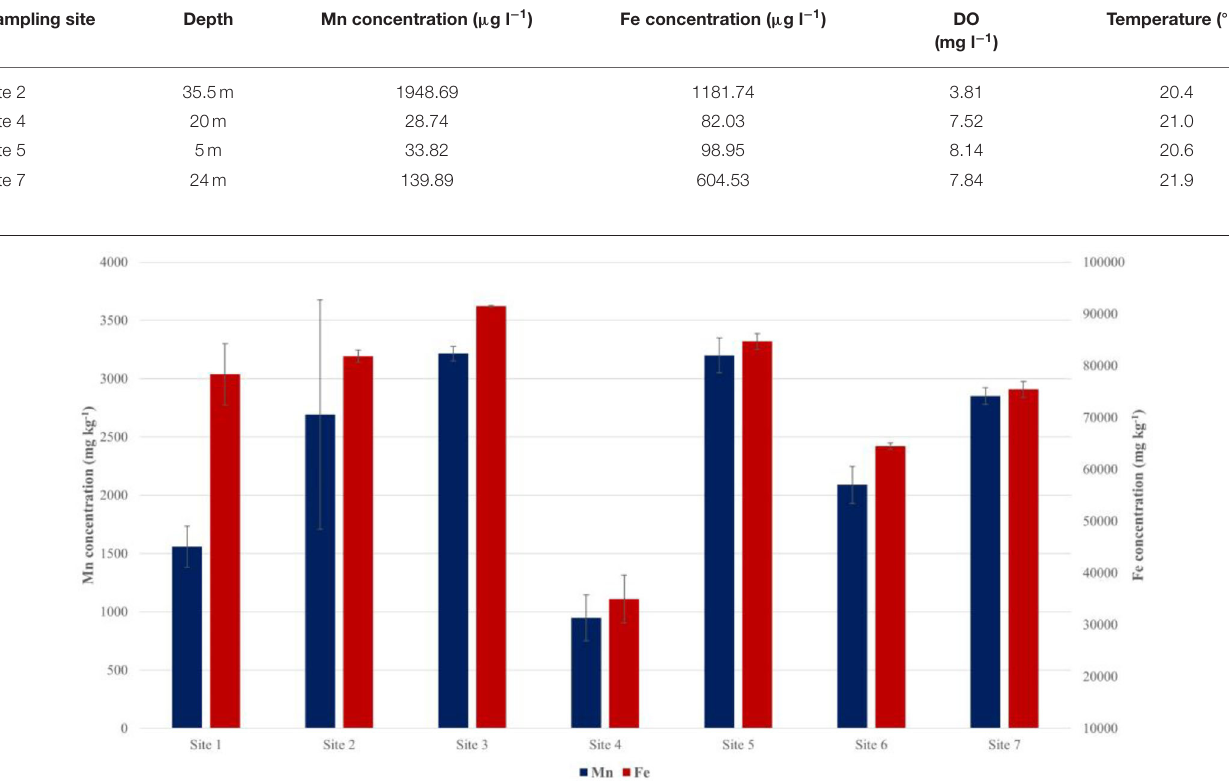
FIGURE 4 | Manganese and iron concentrations in sediment sampled on May